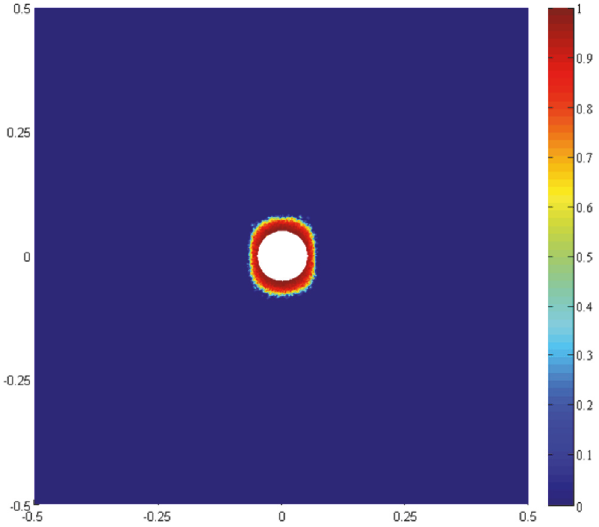
Figure 11: Damage distribution of surrounding rock under lateral pressure coefficient 𝜆 𝜎 = 1.5 .